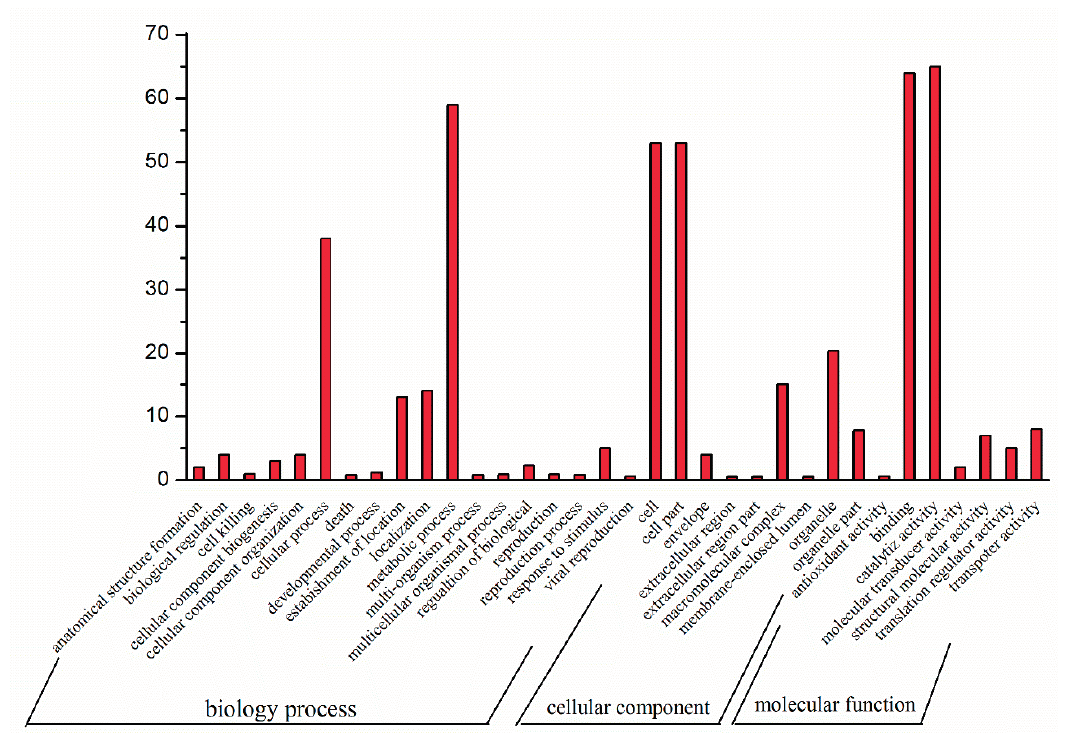
Figure 2. Representation of gene ontology assignments for fungal homologous expressed sequence tags (ESTs) derived from the suppression subtractive hybridization (SSH) library.